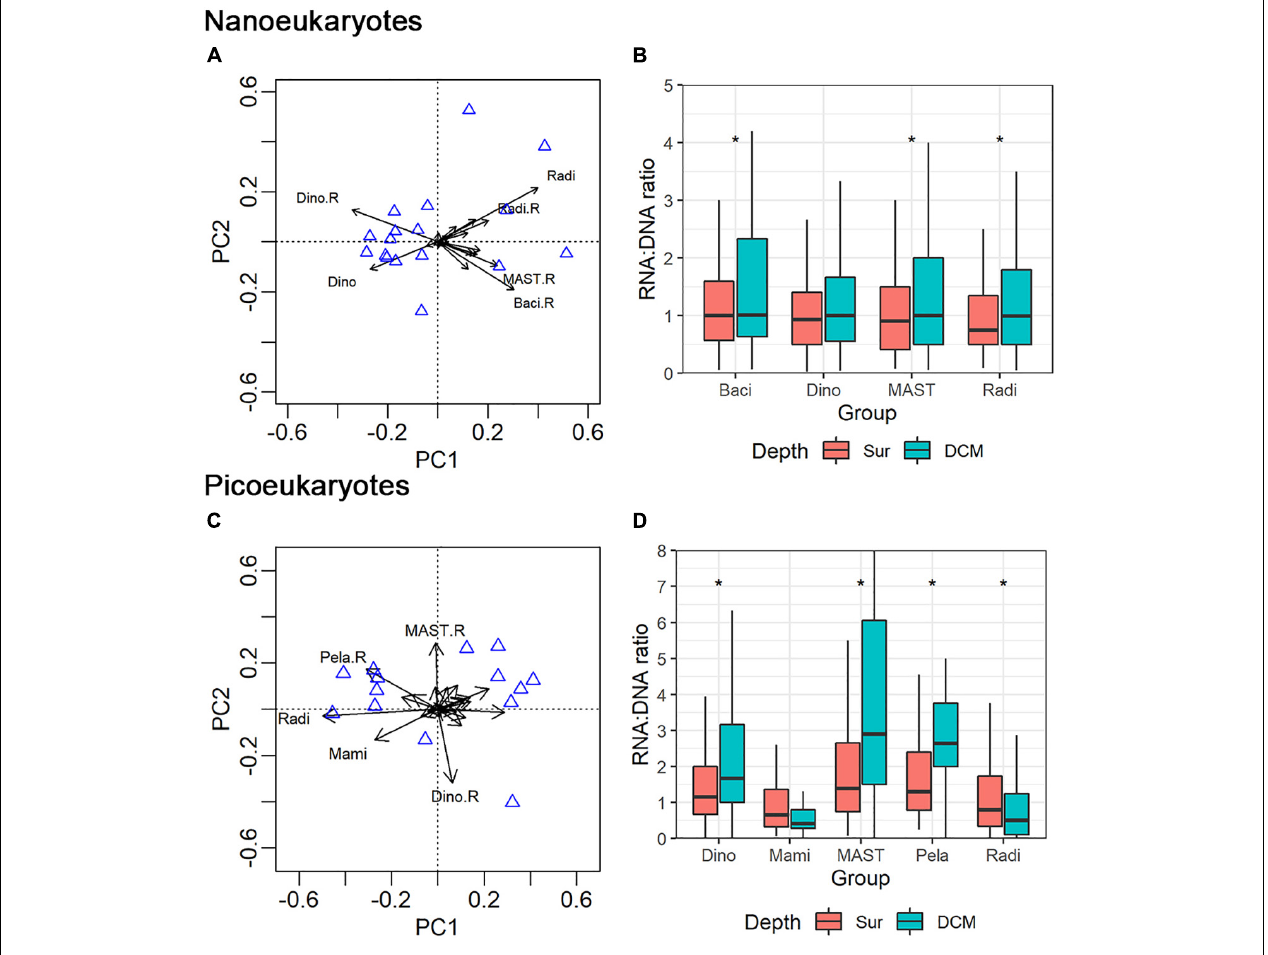
FIGURE 7 | Principal component analysis (PCA) showed the distribution pattern of nano- (A) and pico-eukaryotic (C) major groups (mainly at class level) in combined DNA and RNA samples. Range of RNA: DNA ratios of the major groups of nano- (B) and pico-eukaryotes (D) at surface and DCM layers. Mam: Mamiellophyceae; Pel: Pelagophyceae; Rad: Radiolaria; Dino: Dionophyceae; Baci: Bacillariophyta. The asterisk indicates significant level at p <